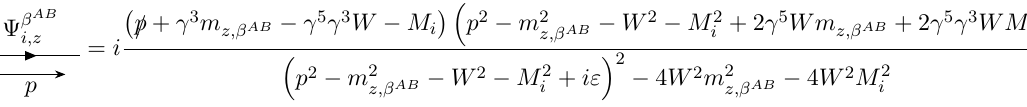
of (A.6), and global- z,β AB